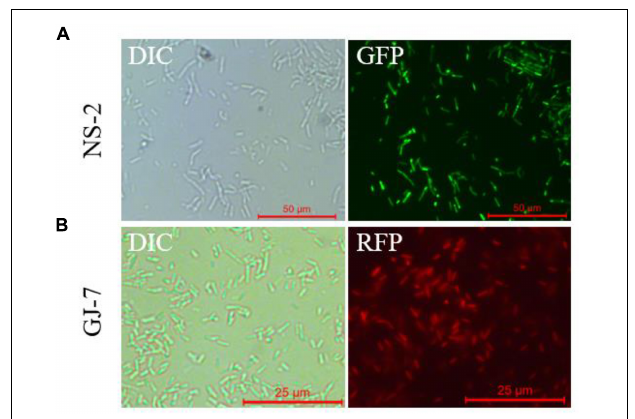
FIGURE 4 | Fluorescence observation of NS-2 and GJ-7 under microscopy. DIC, differential interference contrast field; RFP, red fluorescent field; and GFP, green fluorescent field. Representative fluorescent micrograph of (A) NS-2 and (B) GJ-7 under a fluorescent